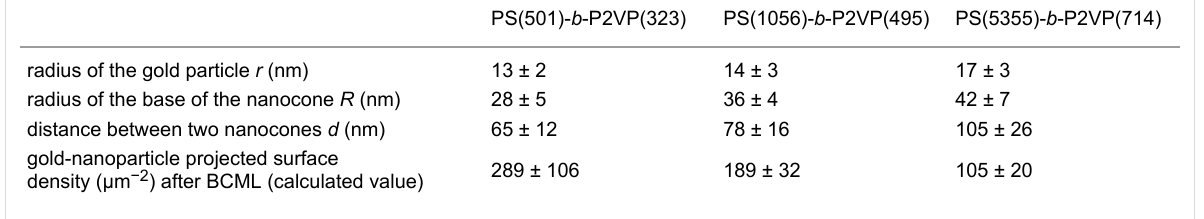
Table 1: Measured ( r , R and d ) and calculated ( N ) dimensions of the nanocone arrays fabricated using three block copolymer solutions (PS(501)- b - P2VP(323), PS(1056)- b -P2VP(495), and PS(5355)- b -P2VP(714)).